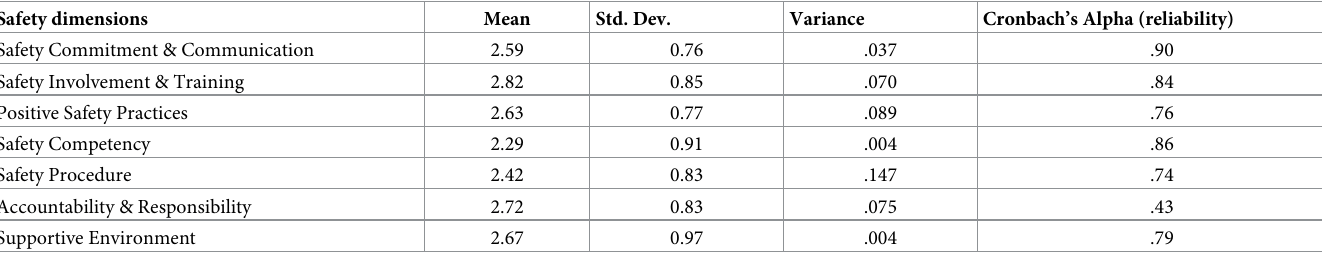
Table 5. Summary of dimensions mean